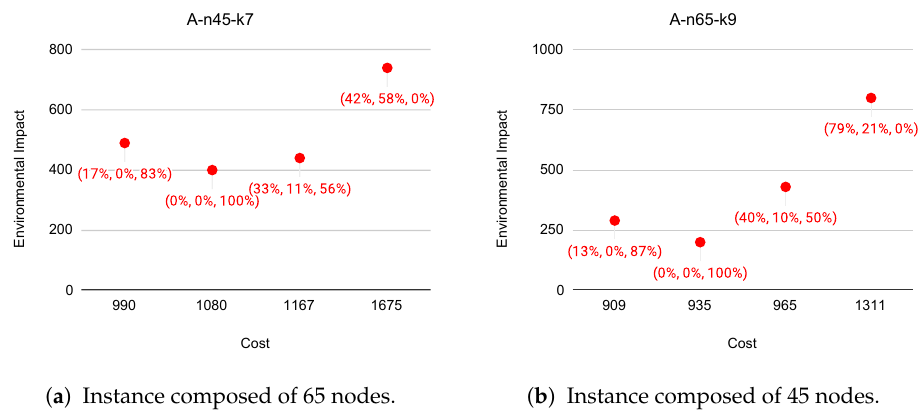
Figure 7. Trade-off between environmental and economical